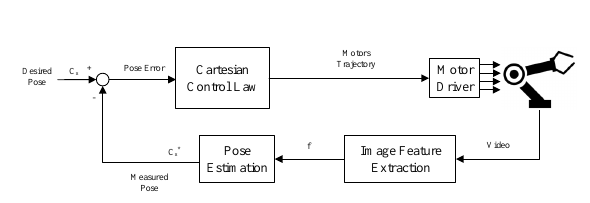
Figure 8. PositionBased ImageServoingblockdiagram[7]